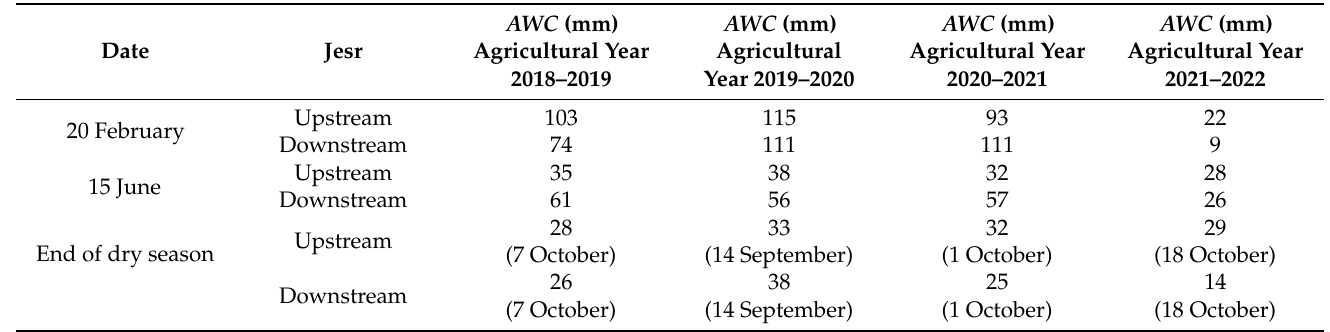
Table 4. AWC (mm) at three specific times of the agricultural year in the upstream and downstream